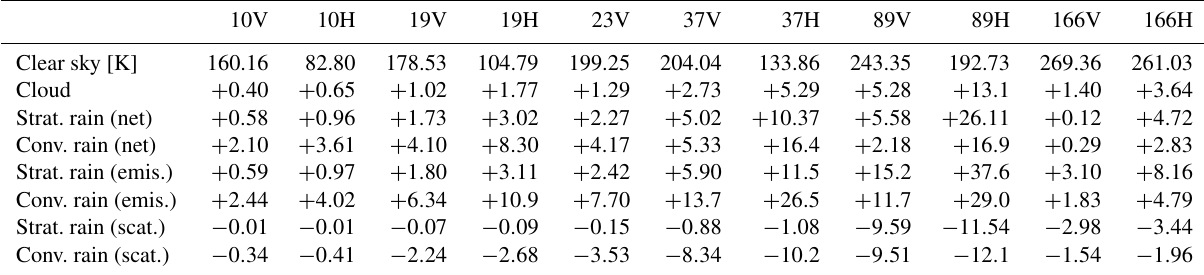
Table 1. Effects on T B at top of atmosphere from cloud water and rainwater alone. Surface conditions are SST = 281K and wind = 5ms − 1 , with water vapour and temperature profiles representative of such an ocean scene. Liquid water path is 100gm − 2 for both rain and cloud water. In both cases the hydrometeors reside between 925 and 975hPa. GMI’s 183GHz channels are not included due to the invariance of water vapour here. Radiometric signals from rainwater are separated into emission (emis.) and scattering (scat.) as described in the text, with the net effect also given. All units are (cid:49)K except for the top row, which is in